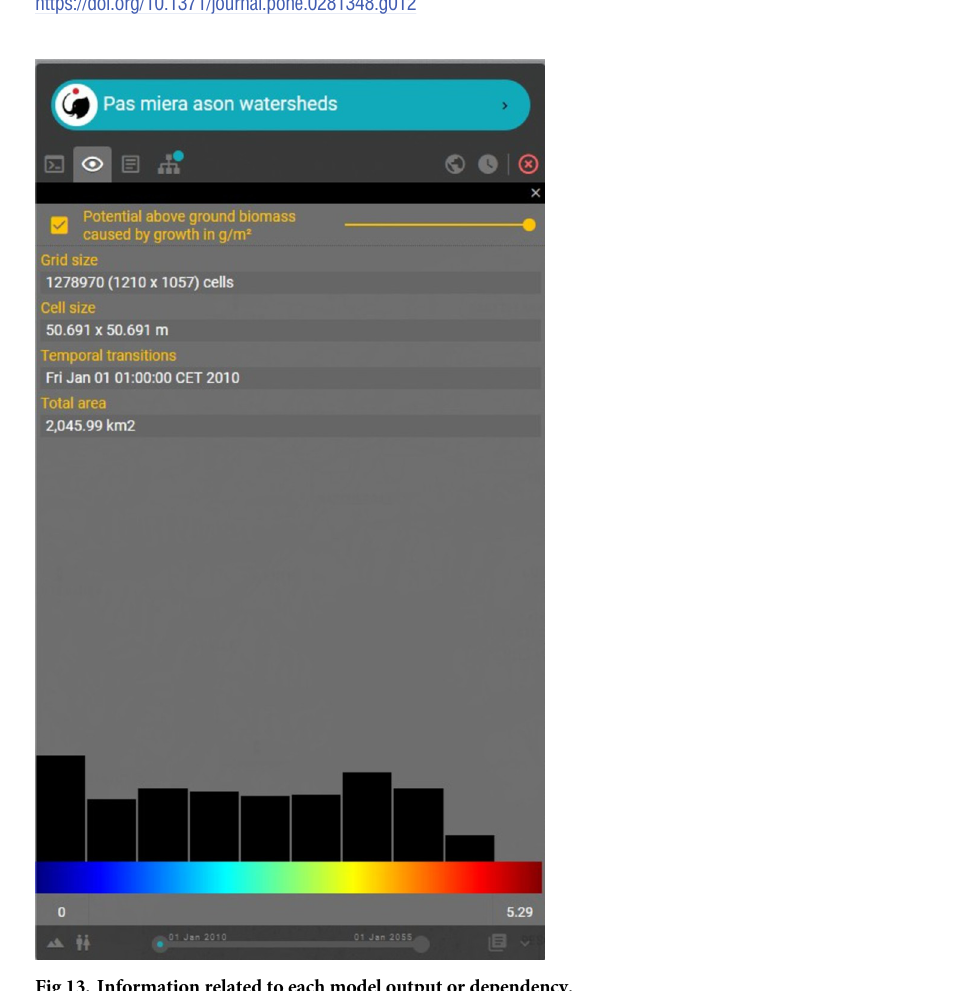
Fig 13. Information related to each model output or